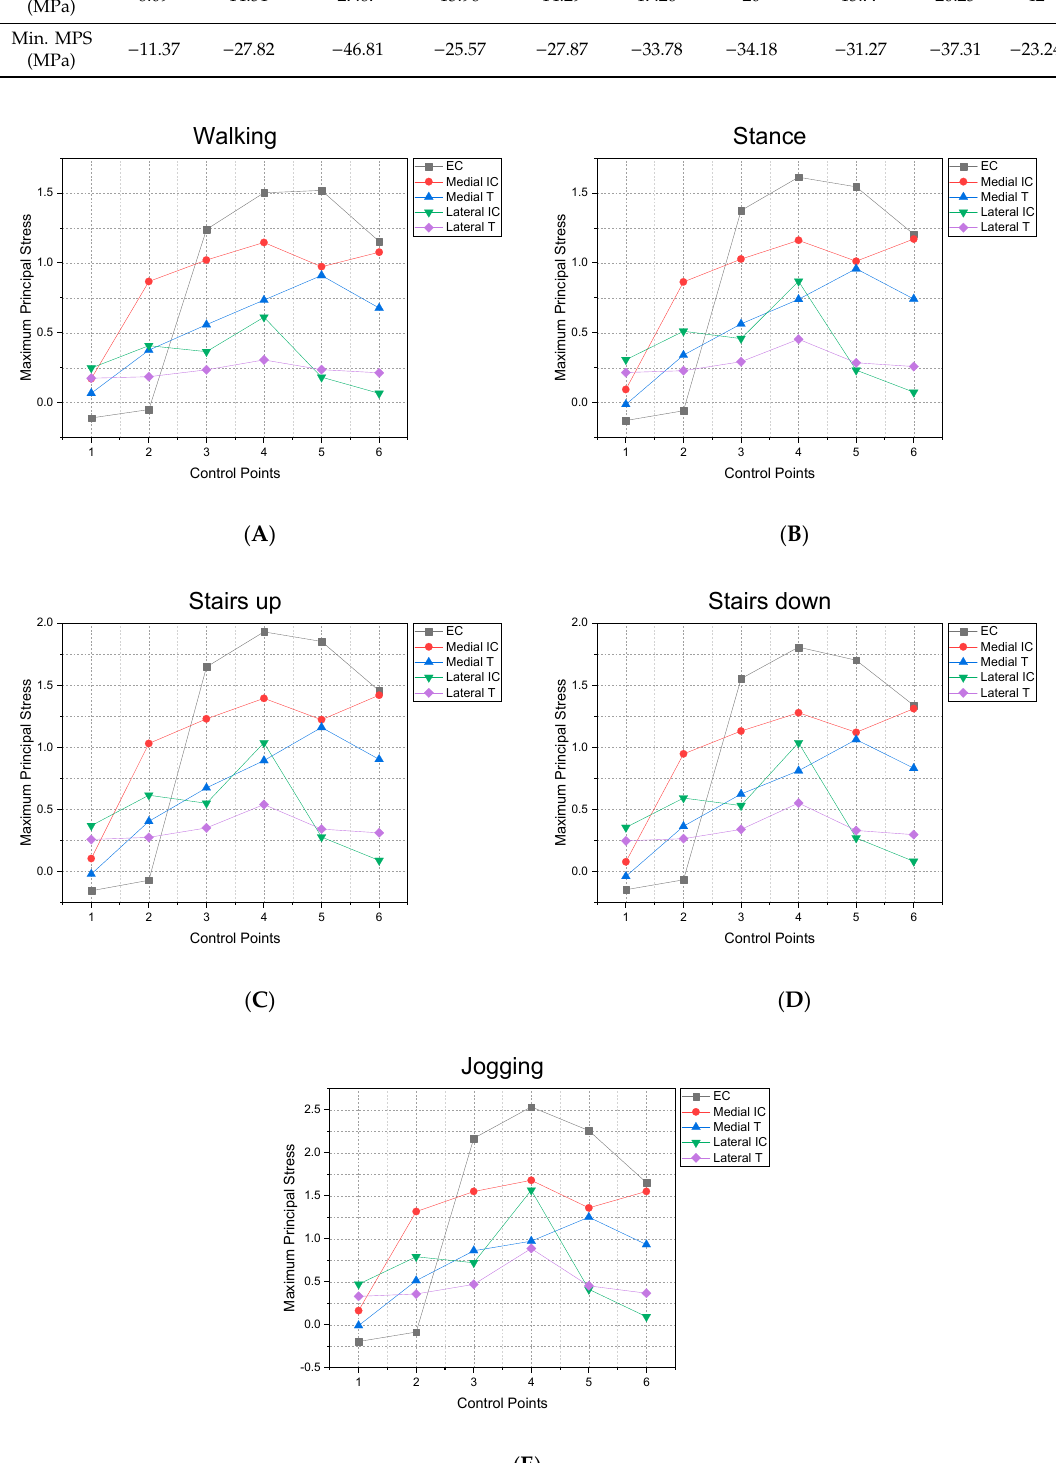
Figure 6. Maximum principal stresses (MPS) occurring at the control points when applying ( A ) walking, ( B ) staying, walking up ( C ) and down ( D ) stairs and ( E ) jogging loads.